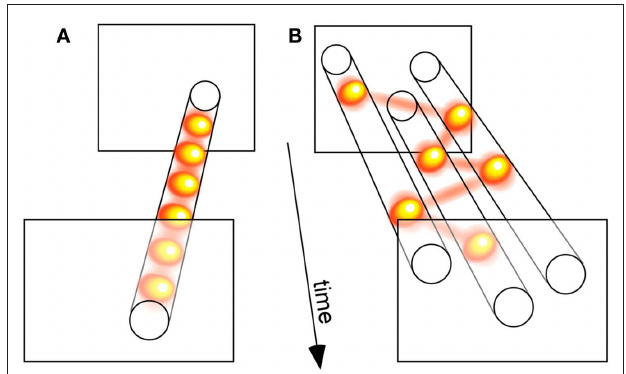
Figure 3 | relating discrete perception with sequential attention. (A) A sensory process that samples a single visual input periodically illustrates the concept of discrete perception. (B) A sensory process that serially samples three simultaneously presented visual stimuli demonstrates the notion of a sequential attention spotlight. Since many of our findings implicate attention in the periodic sampling processes displayed in (A) , we propose that both types of periodic psychological operations (A,B) actually reflect a common oscillatory neuronal process. According to this view, the spotlight of attention is intrinsically rhythmic, which gives it both the ability to rapidly scan multiple objects, and to discretely sample a single source. (The yellow balls linked by red lines illustrate successive